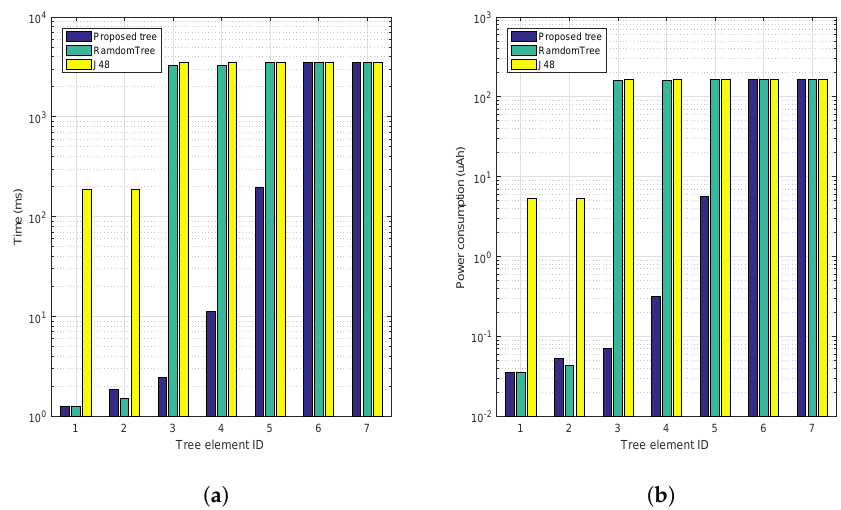
Figure 8. Time and energy consumption corresponding to the different tree levels. ( a ) Time overhead analysis; ( b ) Energy consumption analysis.